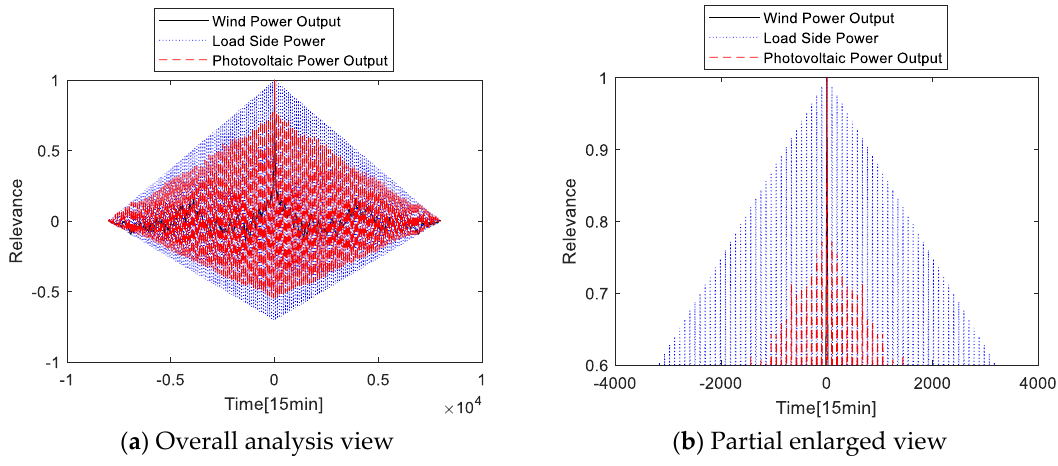
Figure 10. Autocorrelation analysis results of each object in the No. 2 power system.